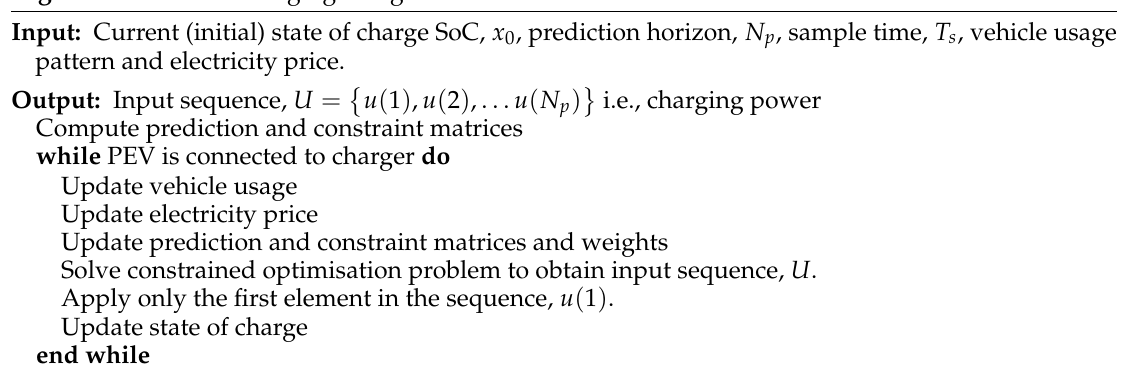
Algorithm 1 Vehicle charging using